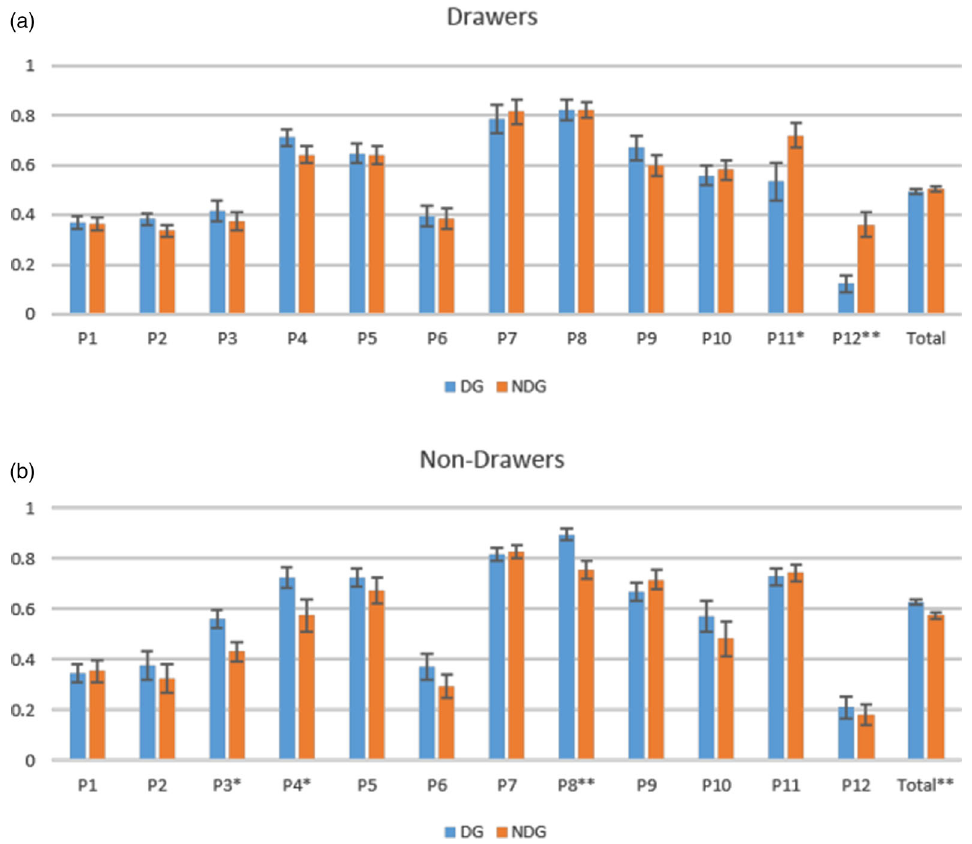
FIG. 5. Comparing the percentage of first attempt correct rate between the two conditions for “ drawers ” (a) and “ nondrawers ” (b). *Difference is significant at the 0.05 level. ** Difference is significant at the 0.01 level. (chi-squared